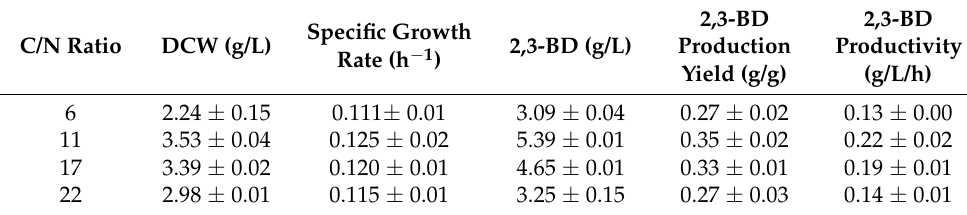
Table 3. Effect of different carbon to nitrogen (C/N) molar ratios on bacterial growth and 2,3-BD production by B. subtilis at 24 h cultivated under aerobic conditions in MMRS